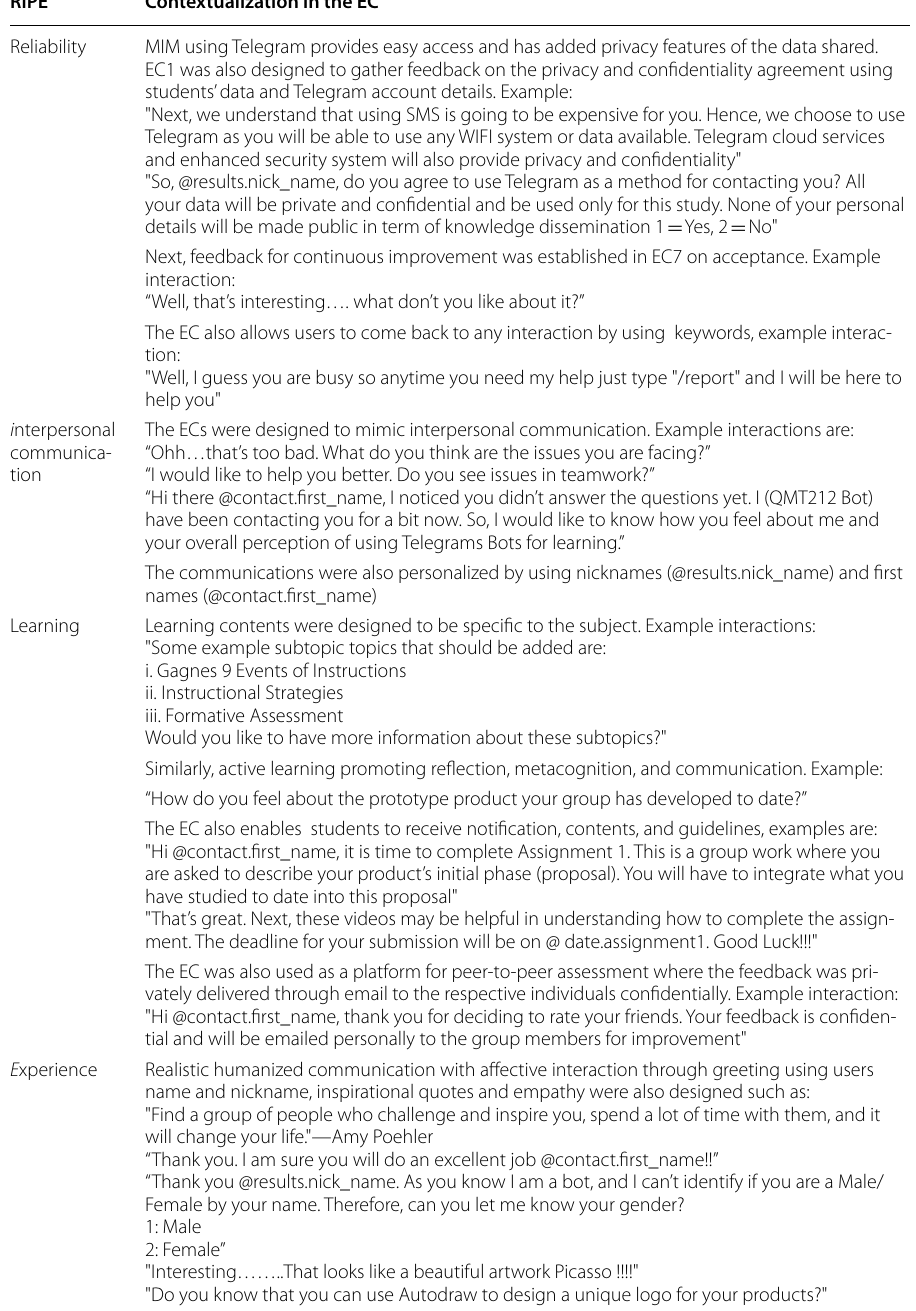
Table 5 Conceptualization of RiPE in the design of the EC RiPE Contextualization in the EC